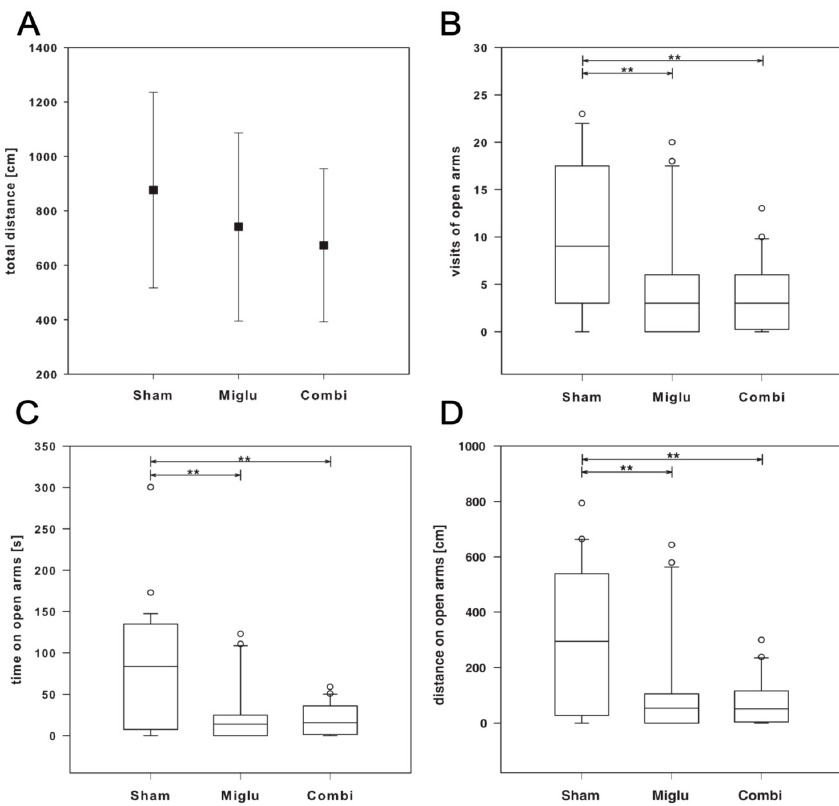
Figure 4. Elevated plus maze test (EPM). ( A ) Motor activity ( n sham = 29, n miglu = 20, n combi = 20) was not altered in treated mice as shown by total walking distance, which did not differ significantly between groups ( p = 0.103); ( B ) number of visits of open arms; ( C ) distance on open arms; ( D ) time on open arms. Asterisks indicate significant differences compared to the sham group (** p < 0.01). Data of scatter plot are represented as mean ± SD. Box plots depict the groups graphically by displaying the following descriptive statistical parameters: the median, the upper and lower quartiles, and outliers (circles) that lie outside the 10th and 90th percentiles (whiskers).